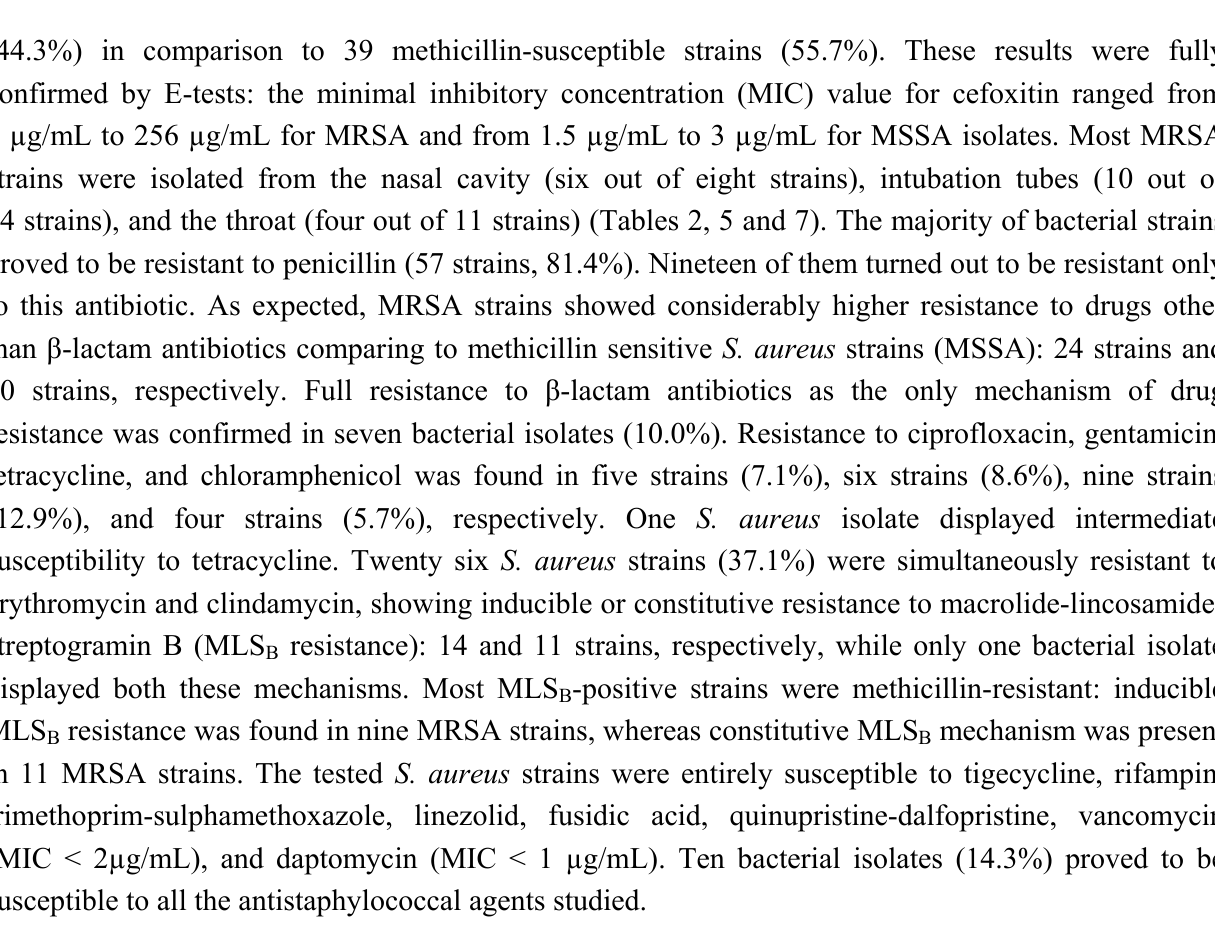
Table 2. Characteristics of S. aureus strains isolated from the nasal